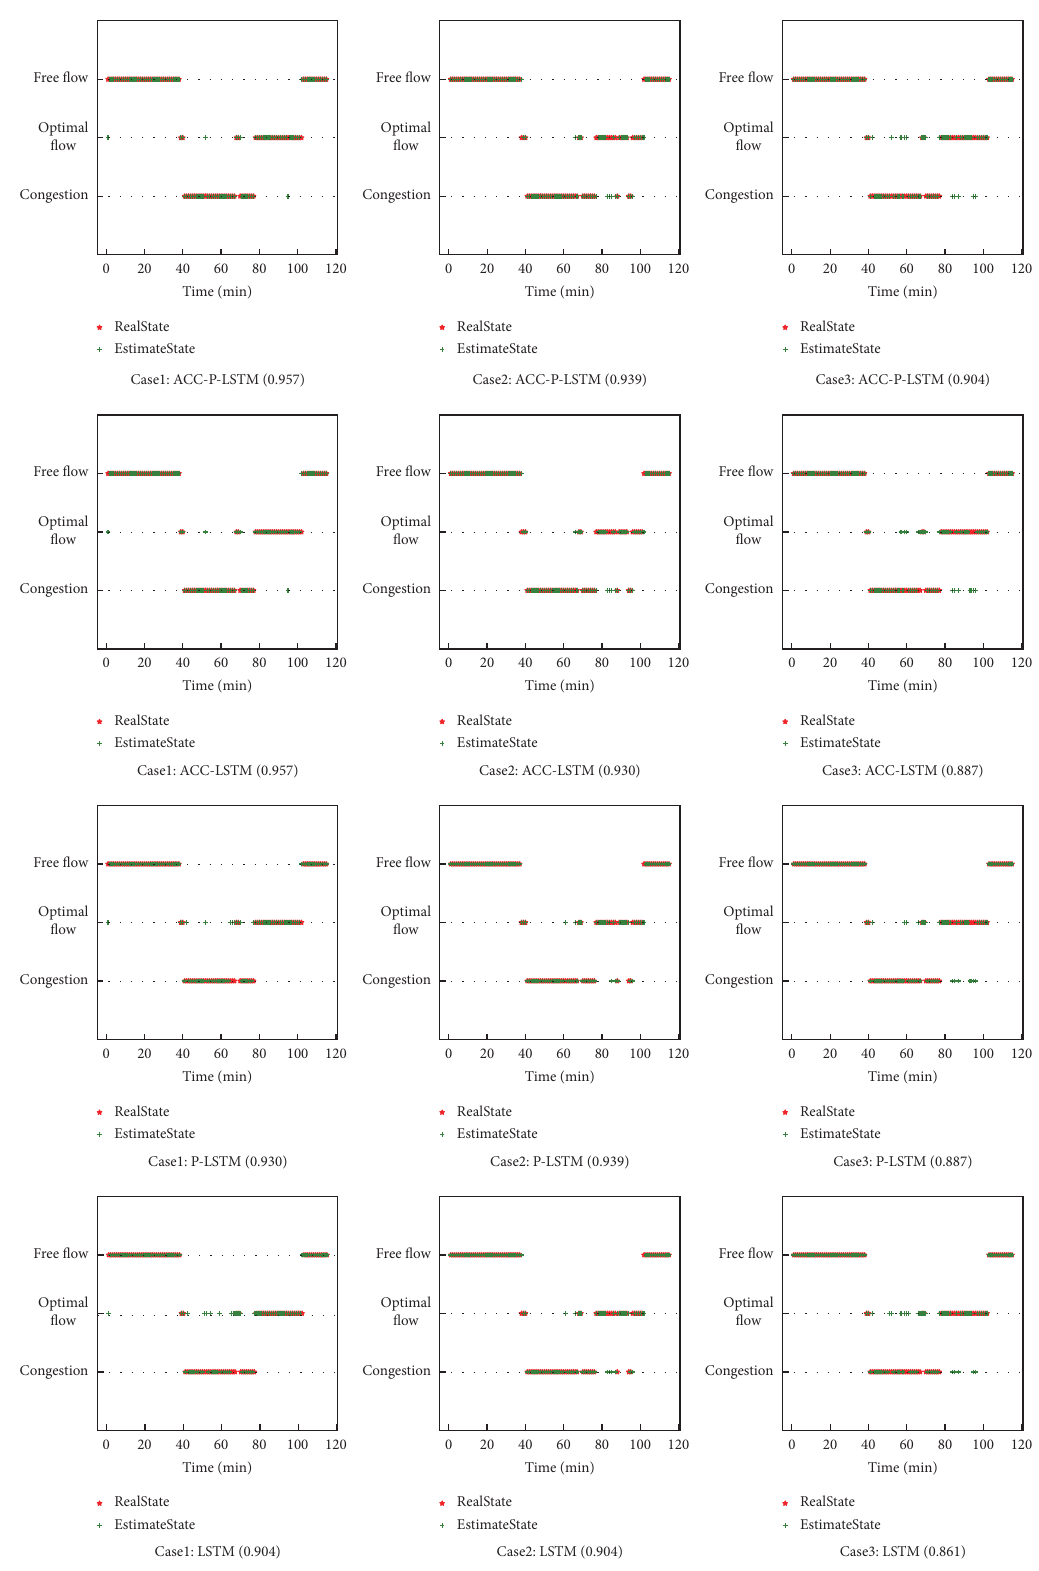
Figure 7: Comparison of traffic state estimation of various models under different penetration rates (the accuracy is recorded in the brackets of the subgraphs). Note: LSTM � Long Short-Term Memory; KF � Kalman Filtering; ACC-P-LSTM � LSTM model using KNN filling with fusion acceleration and penetration rate estimation; P-LSTM � LSTM model using penetration rate estimation; ACC-LSTM � LSTM model using KNN filling with fusion acceleration; and ACC-KF � Kalman Filtering using KNN filling with fusion